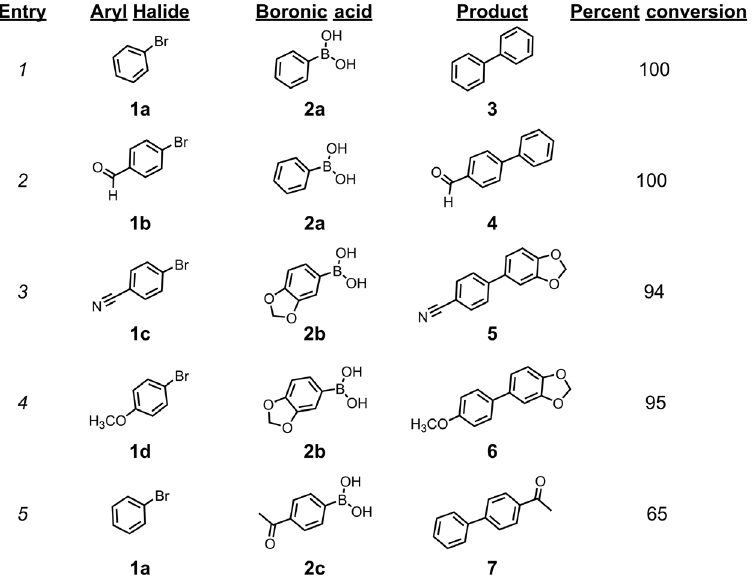
Figure 3: Suzuki-Miyaura reactions were completed under traditional batch conditions.Reactions were carried out by combining an aryl halide (0.27 mmol), a substituted boronic acid (0.32 mmol), K irradiating in the microwave at 80 ° C for 10 min.